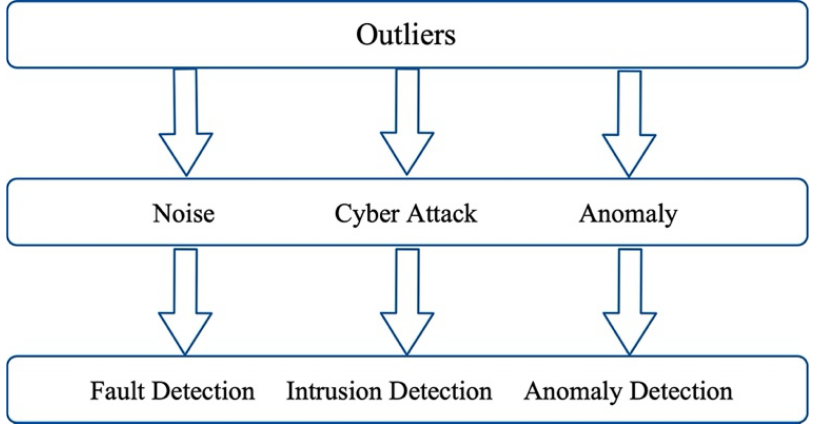
Figure 1. Outliers in the data stream.